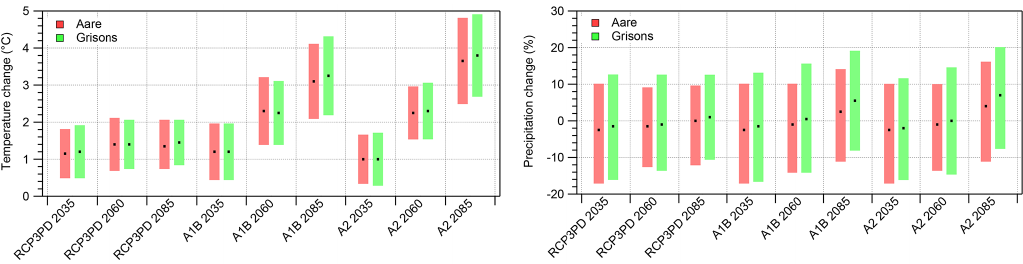
Figure 2. Mean January to March temperature (left) and precipitation (right) changes including the uncertainty bars from the upper and lower estimates for the Aare (red) and the Grisons (green) region.